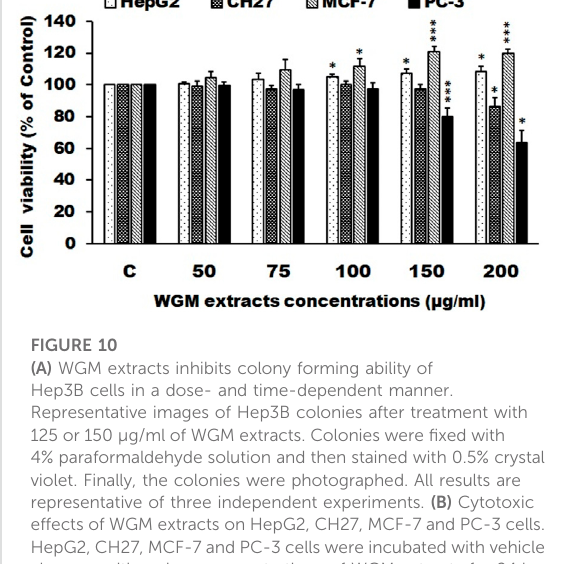
FIGURE 10 (A) WGM extracts inhibits colony forming ability of Hep3B cells in a dose- and time-dependent manner. Representative images of Hep3B colonies after treatment with 125 or 150 μ g/ml of WGM extracts. Colonies were fi xed with 4% paraformaldehyde solution and then stained with 0.5% crystal violet. Finally, the colonies were photographed. All results are representative of three independent experiments. (B) Cytotoxic effects of WGM extracts on HepG2, CH27, MCF-7 and PC-3 cells. HepG2, CH27, MCF-7 and PC-3 cells were incubated with vehicle alone or with various concentrations of WGM extracts for 24 h. After treatment, the viable cells were measured by MTT assay. The data are expressed as the mean % control ±S.D. of three independentexperimentsperformedinduplicate.* p < 0.05,*** p < 0.001 compared to the control